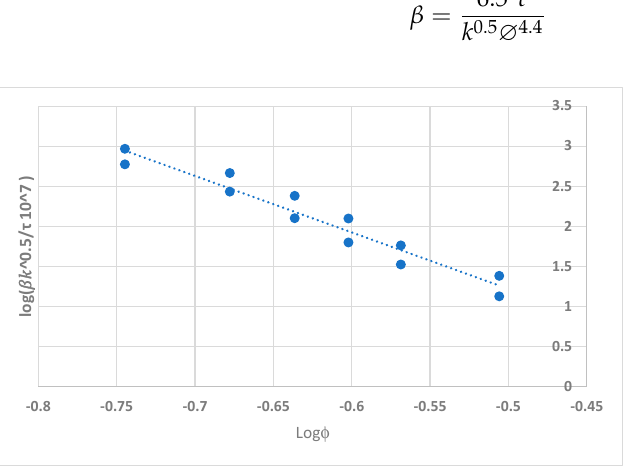
Figure 12. The non-Darcy coefficient with the effect of tortuosity for the seven samples resulted from two different air and water experiments. Finally, both obtained novelty correlations as illustrated in Equations (23) and (24) not only distinguished that they are consistent in terms of units; but in addition, they are correct compared to many correlations found in the literature. It was noted that many of them are incorrect in terms of units. However, our reliable experimental results as shown in Figures 13 and 14 were obtained based on radial flow experiments and large samples.